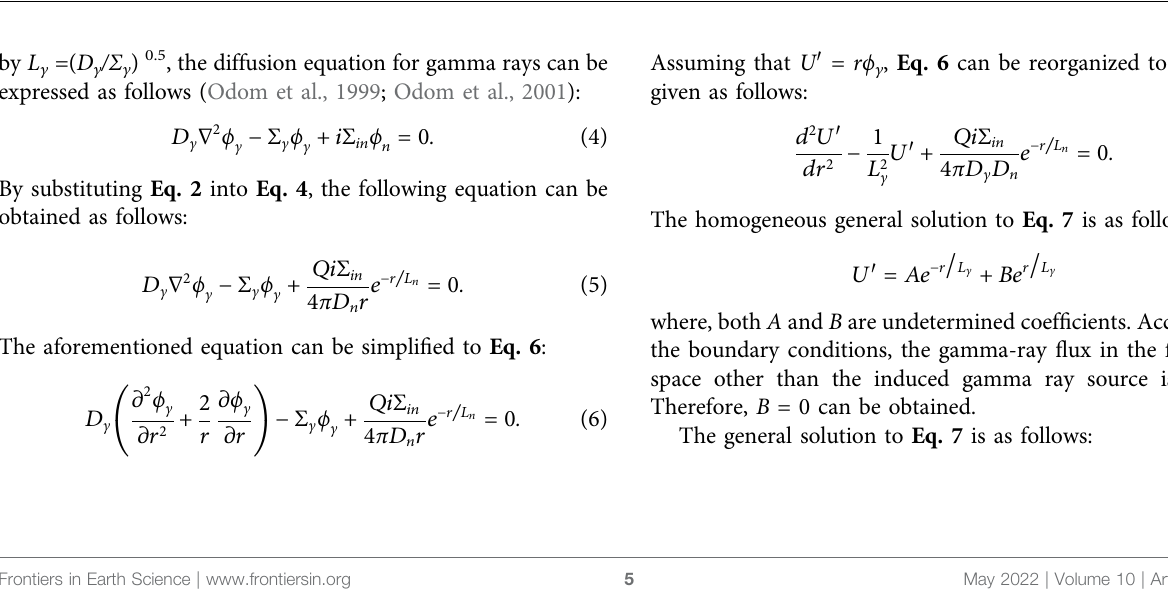
FIGURE 6 | Cross-plot of count ratio and bulk density for various mineral and fl uid combinations. (A) Inelastic scattering gamma ray count ratio; (B) neutron count ratio.